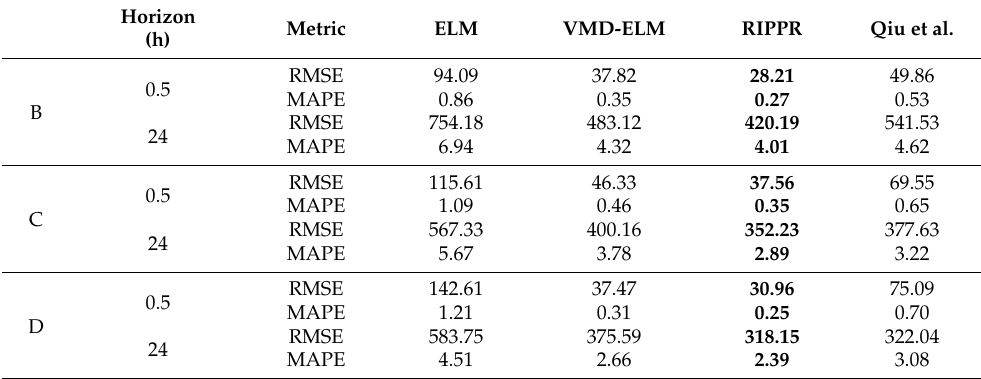
Table 4. Results comparison for datasets B, C and D.